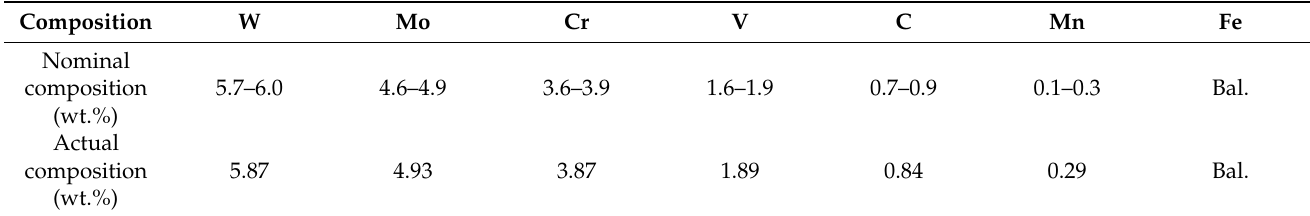
Table 1. Chemical composition of the M2HSS powder